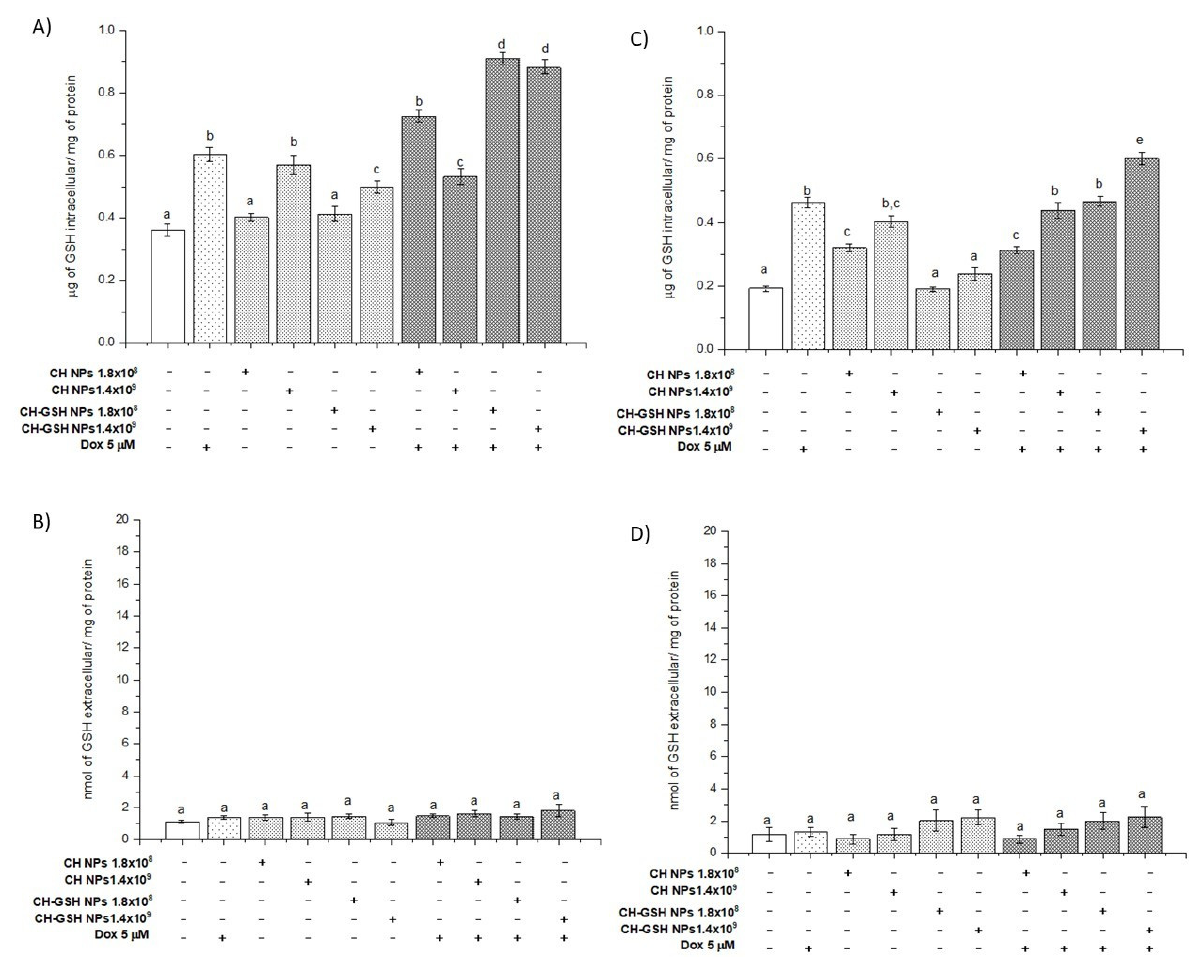
Figure 4. GSH intra ( A , C ) and extracellular ( B , D ) levels of cells exposed to doxorubicin for 12 h and then 2 h with CH-GSH NPs or CH-NPs. MCF-7 ( A , B ) and MDA MB-231 ( C , D ) cells. Bars with equal letters indicate no significant differences between the means (Tukey’s test, p <